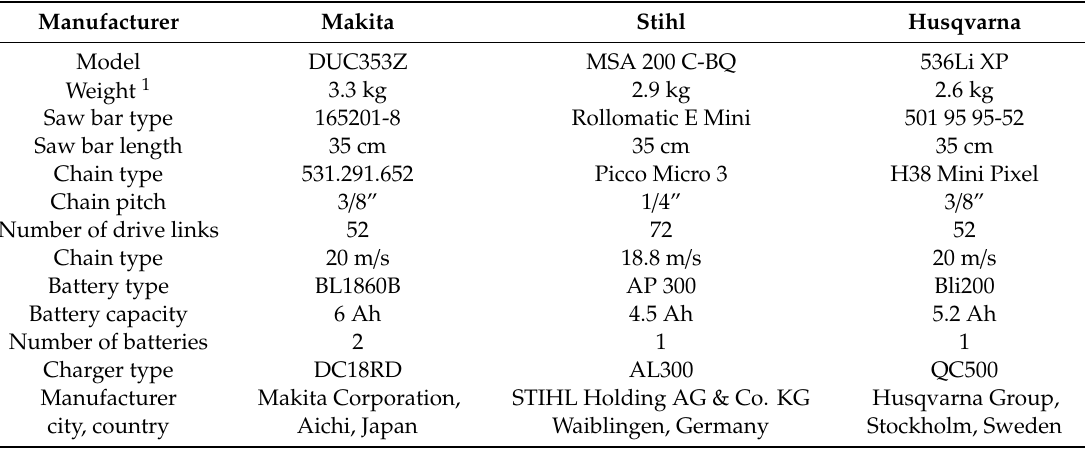
Table 1. Properties of the chainsaws and supplementary equipment.